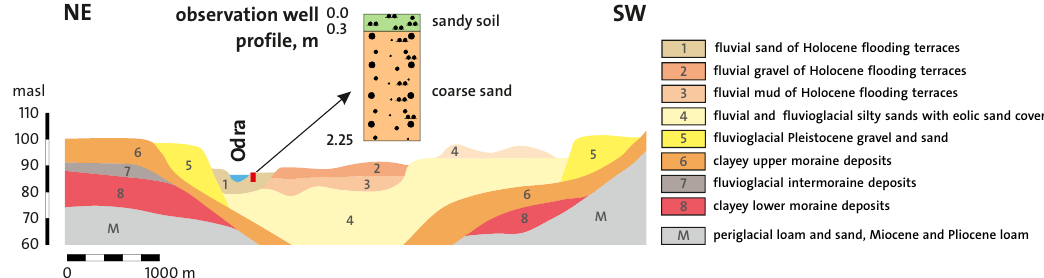
Figure 4. Conceptual geological cross-section through the city of